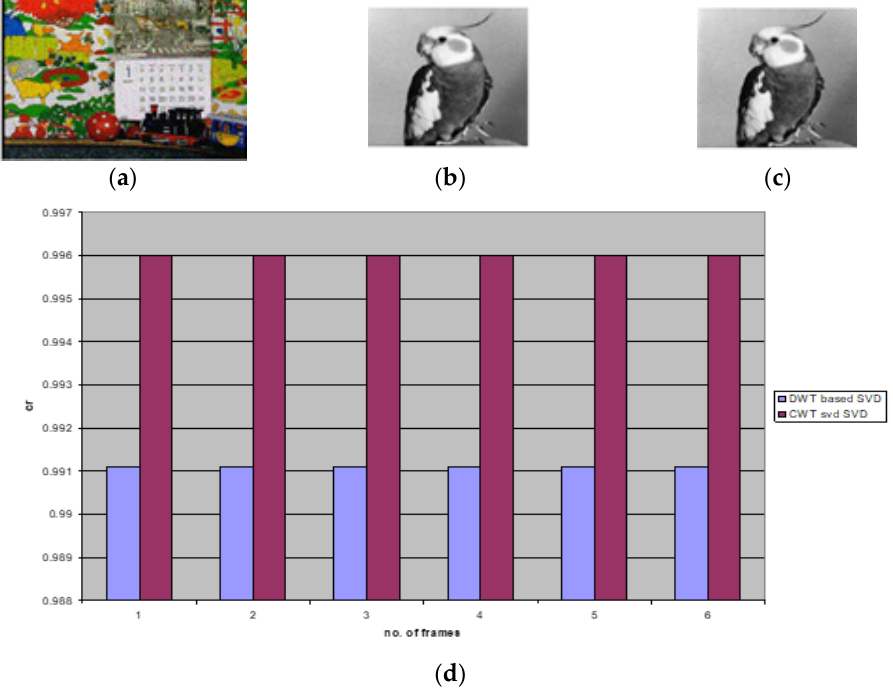
Figure 19. ( a ) The watermarked frame under Gaussian noise attack using the proposed method. ( b ) Extracted watermark from frame 10 of the first video scene in the proposed method. ( c ) Extracted watermark from frame 10 of the first video scene for the DWT-based SVD method. ( d ) Correlation values for the extracted watermarks from each six frames in the first video scene under Gaussian attack with variance 0.01.